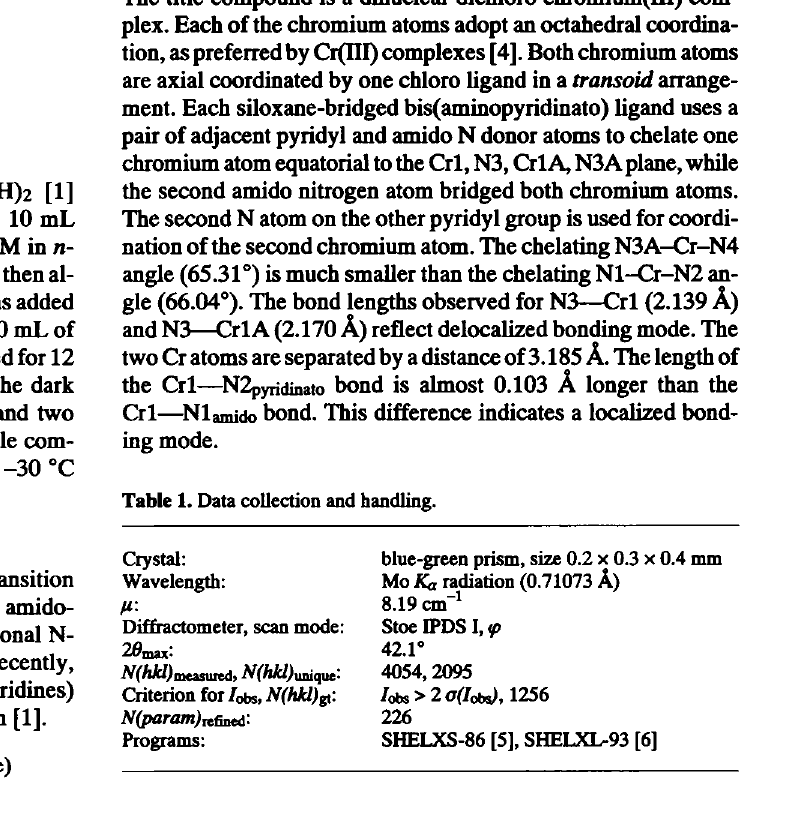
Table 1. Data collection and